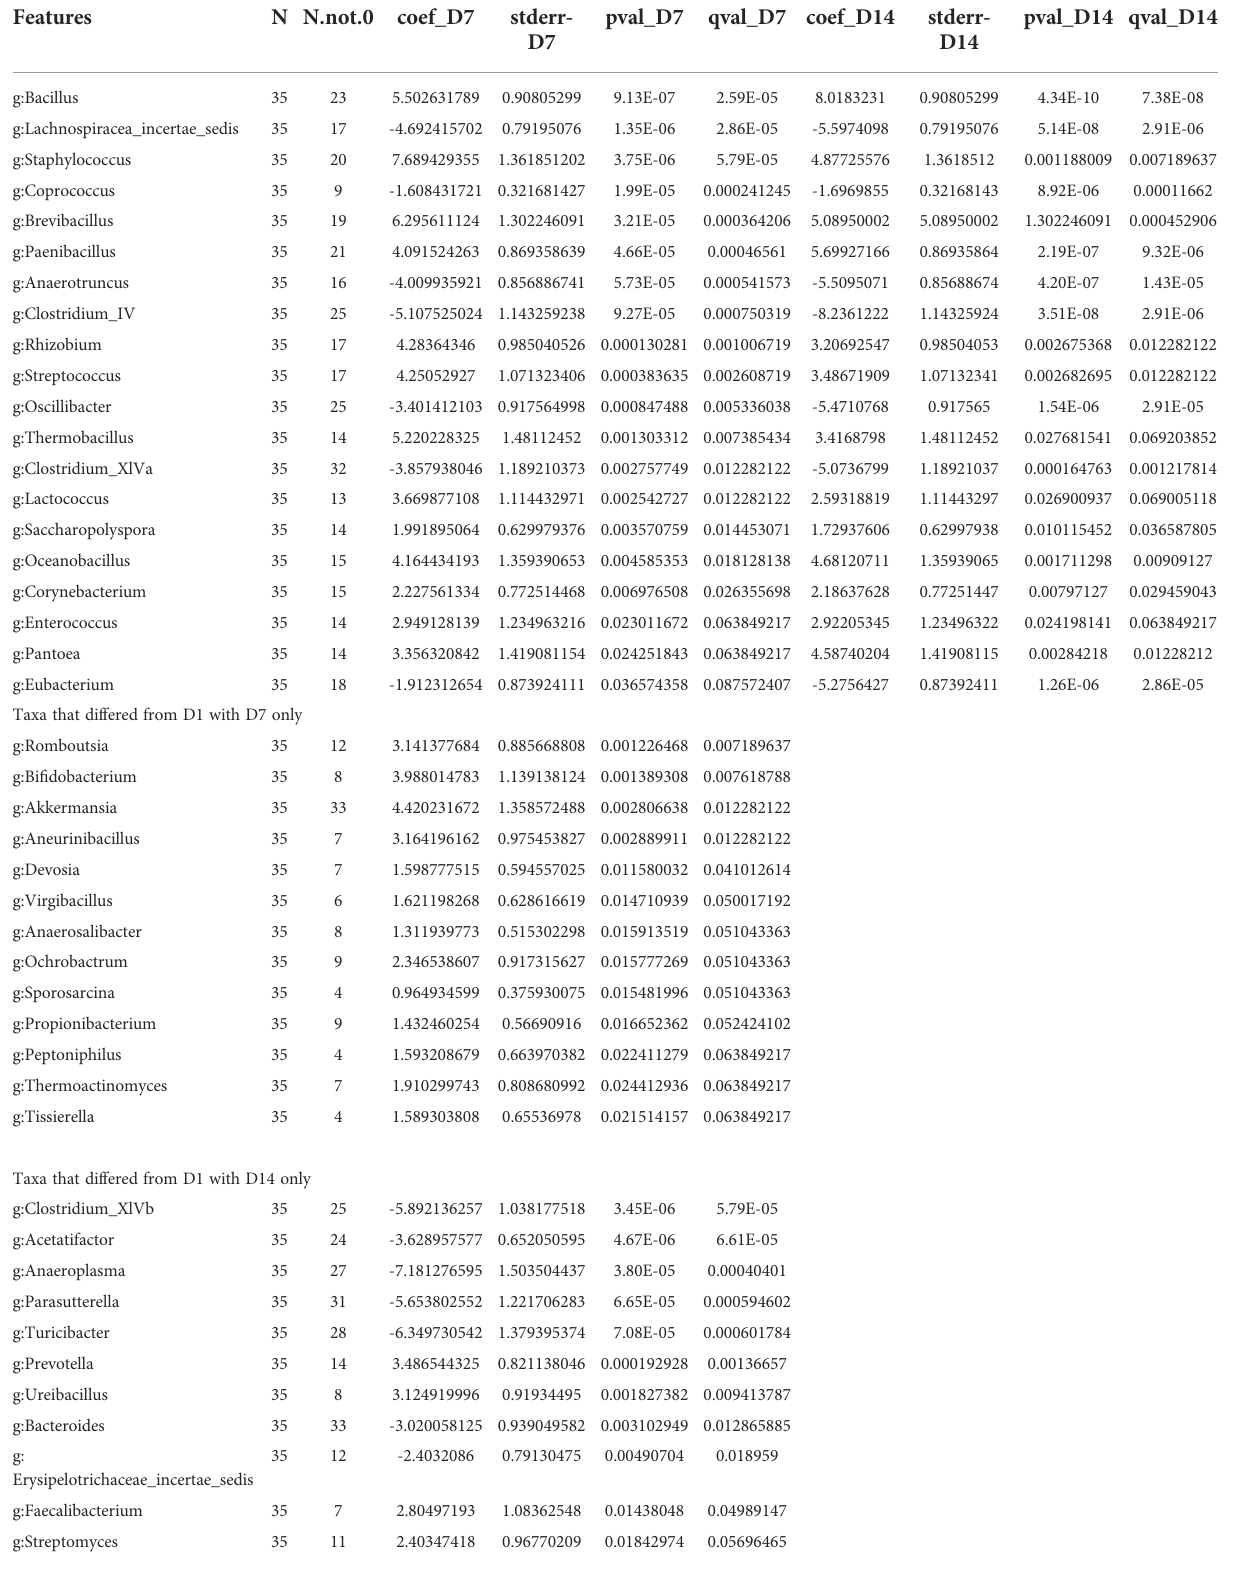
TABLE 1 Taxa that differed as an effect of antibiotics, across D1, D7 and D14 (n=4/per group).